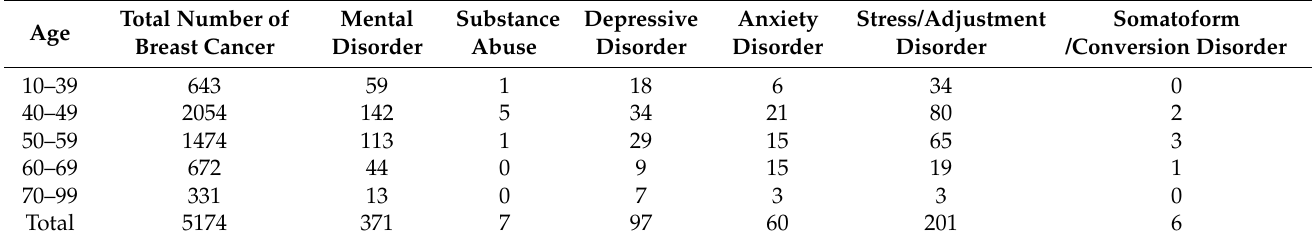
Table 1. The frequency of mental disorders in breast cancer patients ( n = 5174).